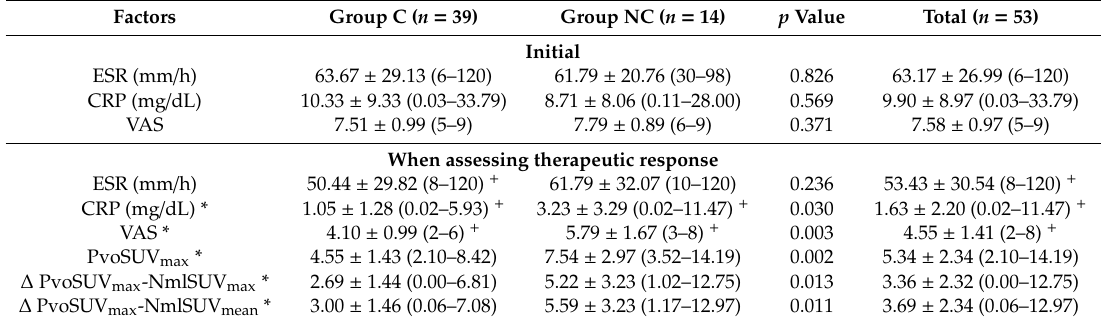
Table 4. Comparison of clinical and radiological features between the groups C and NC.